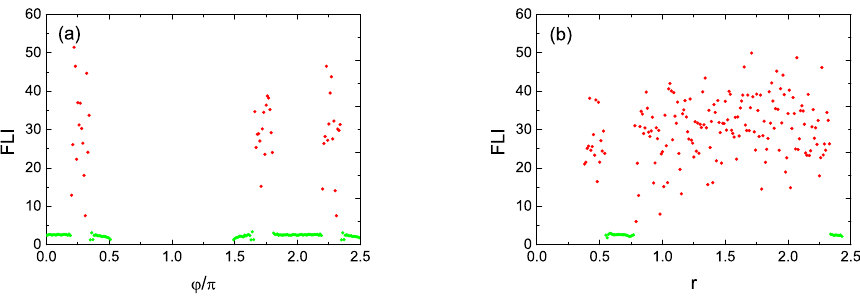
Figure 10. Dependence of FLI on initial value ϕ or r . ( a ) Initial value r = 1.15 is given. ( b ) Initial value ϕ = 0.2 π is fixed. Each of the FLIs is obtained by N4P after integration time t = 1000. The threshold of FLIs between the ordered and chaotic cases is 4. Green corresponds to the regularity of orbits, and Red indicates the chaoticity of orbits. Chaos mainly occurs for the initial values of ϕ in the vicinity of 0.25, 1.75, and 2.25 in ( a ), and it does for the initial values of r in the vicinity of 0.5, and 0.75 ∼ 2.25 in ( b